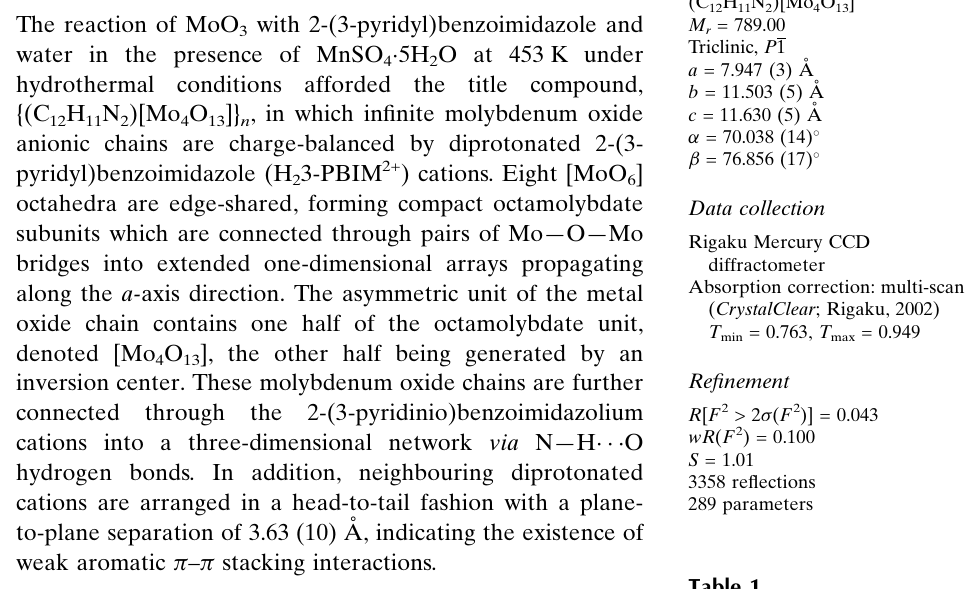
Selected bond lengths (A˚